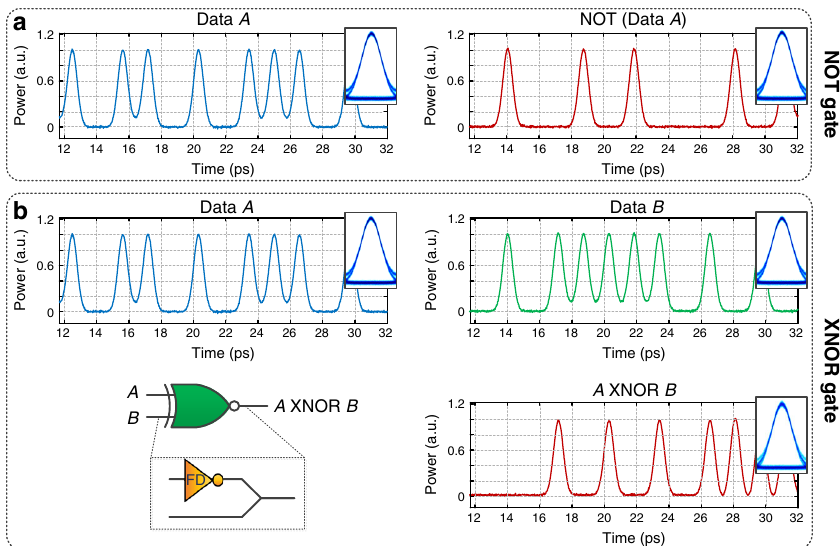
Fig. 3 Demonstration of frequency-domain, passive logic NOT and XNOR gate through numerical simulation. a Left: 13 bits at 640 Gbit/s of a 128 random bit sequence (RBS) input to NOT gate, Right: NOT gate output of same 13 bits, insets: eye diagrams. b Top: 13 bits at 640 Gbit/s of two 128 random bit sequence inputs to the XNOR (Data A and Data B ), Bottom right: corresponding XNOR output of 13 bits from logical operation of Data A and Data B , insets: eye diagrams.